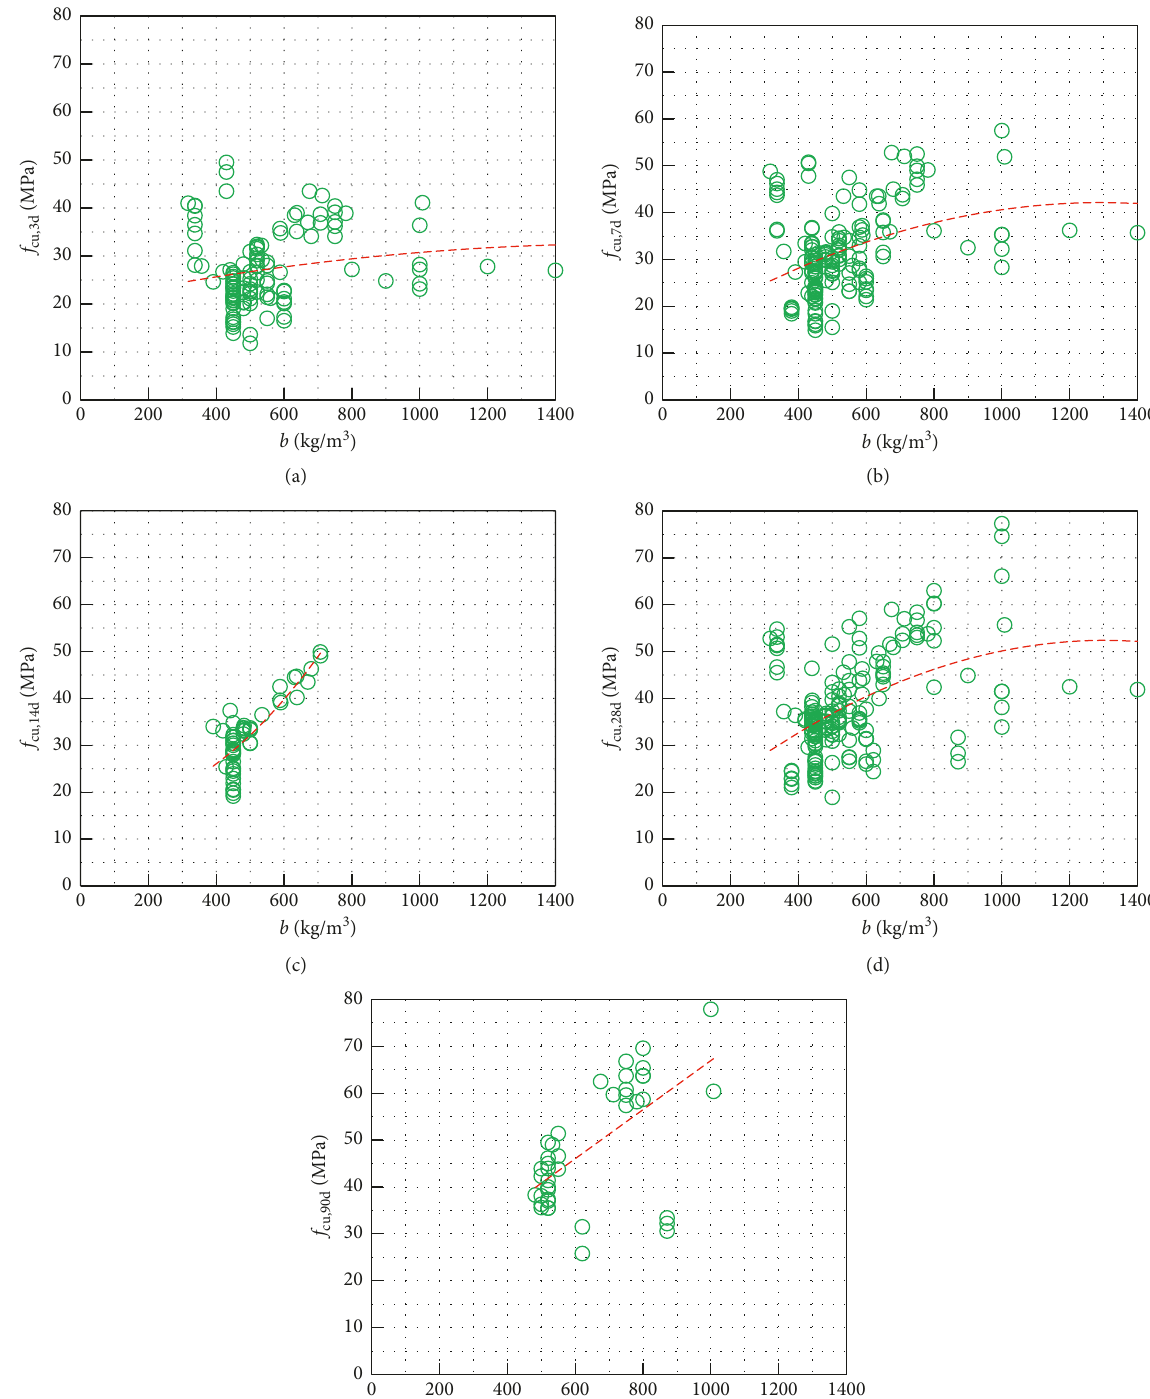
Figure 12: Effect of (m) S /(b) on (f) cu,N . (a) At 3 days. (b) At 7 days. (c) At 14 days. (d) At 28 days. (e) At 90